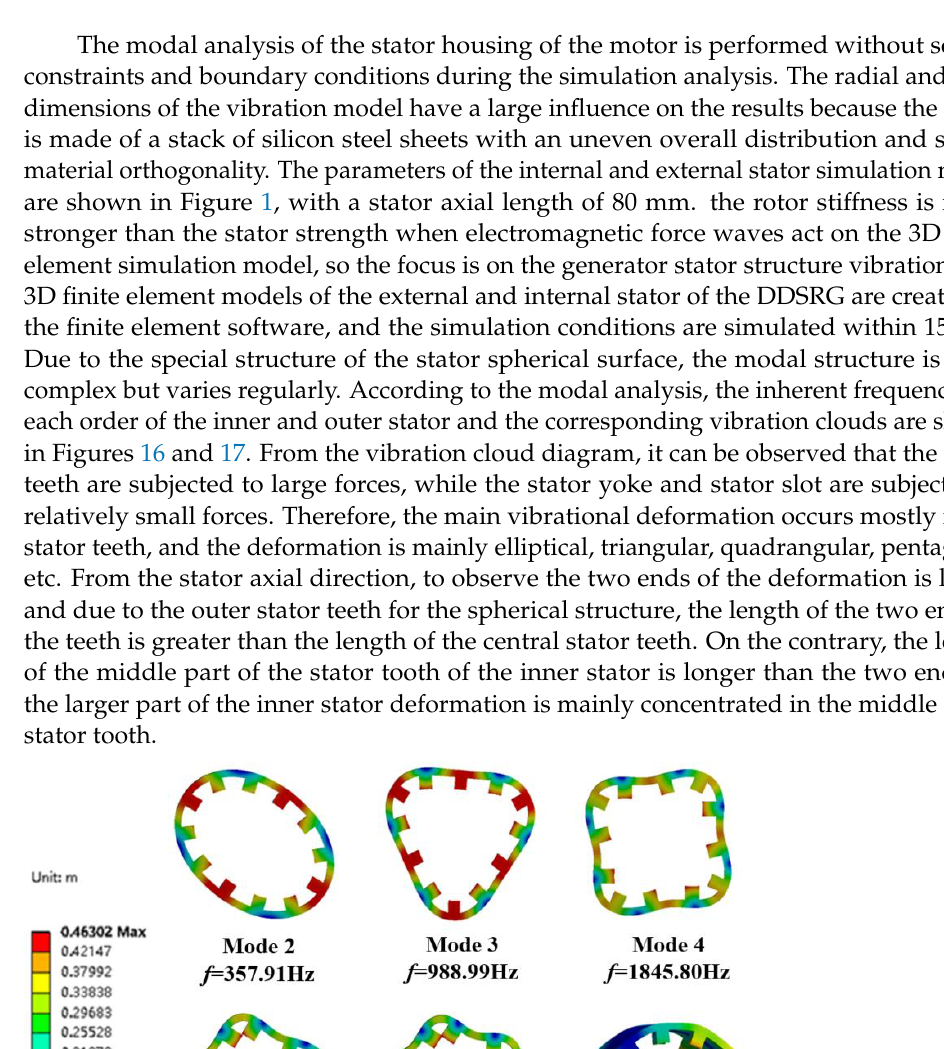
Figure 17. Internal stator modal analysis cloud diagram. The modal analysis has been carried out above on the basis of which the modal vi- bration pattern is superimposed to analyze its vibration characteristics. The harmonic response analysis allows a comprehensive and effective analysis of the intrinsic modal and ERF of the DDSRG. By combining the electromagnetic – structural coupling analysis process in Figure 1, the calculated ERF on the inner surface of the stator is used as the excitation source and coupled to the stator teeth for harmonic response analysis in the